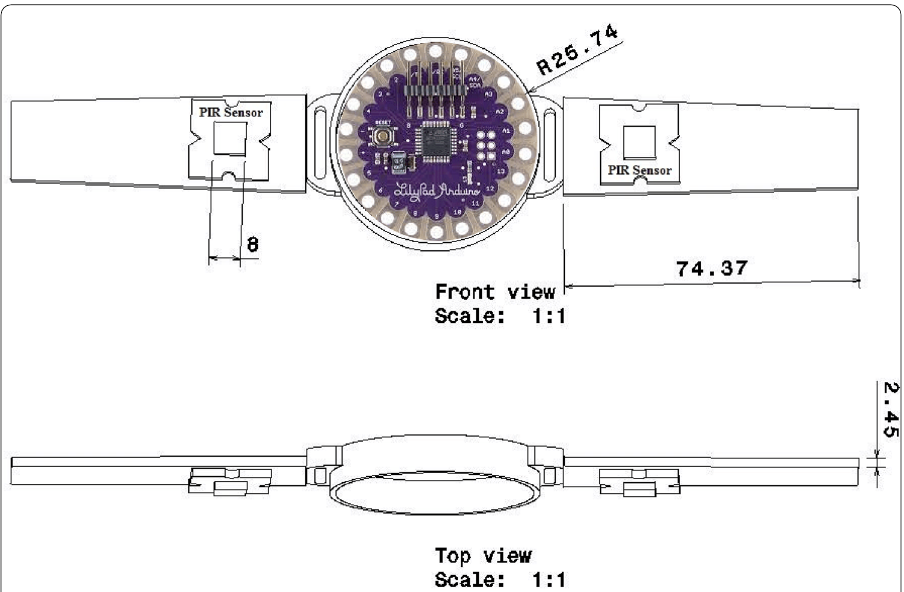
Fig. 3 Schematic diagram of wristband with PIR